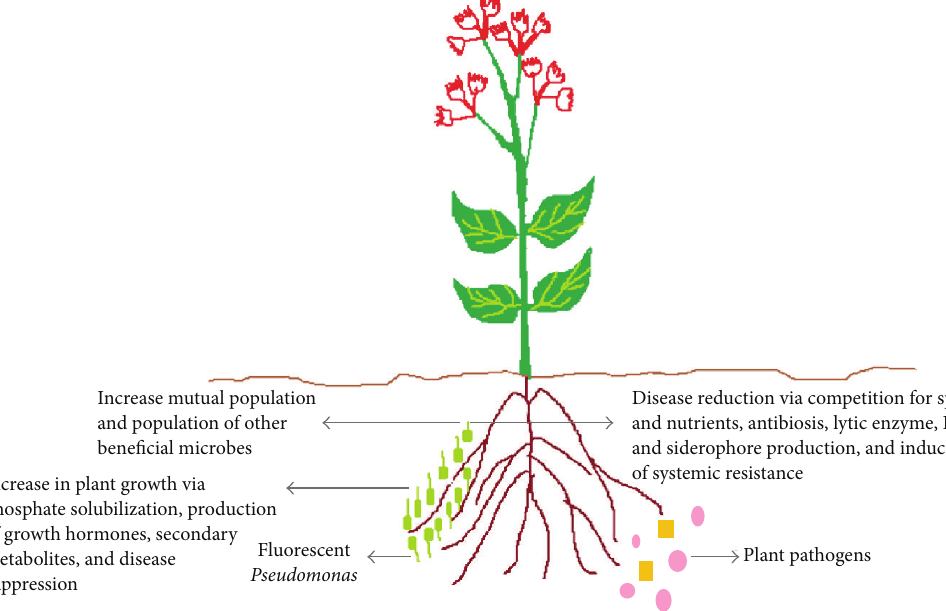
Figure 1: Schematic representation of mechanism of action of fluorescent Pseudomonas in